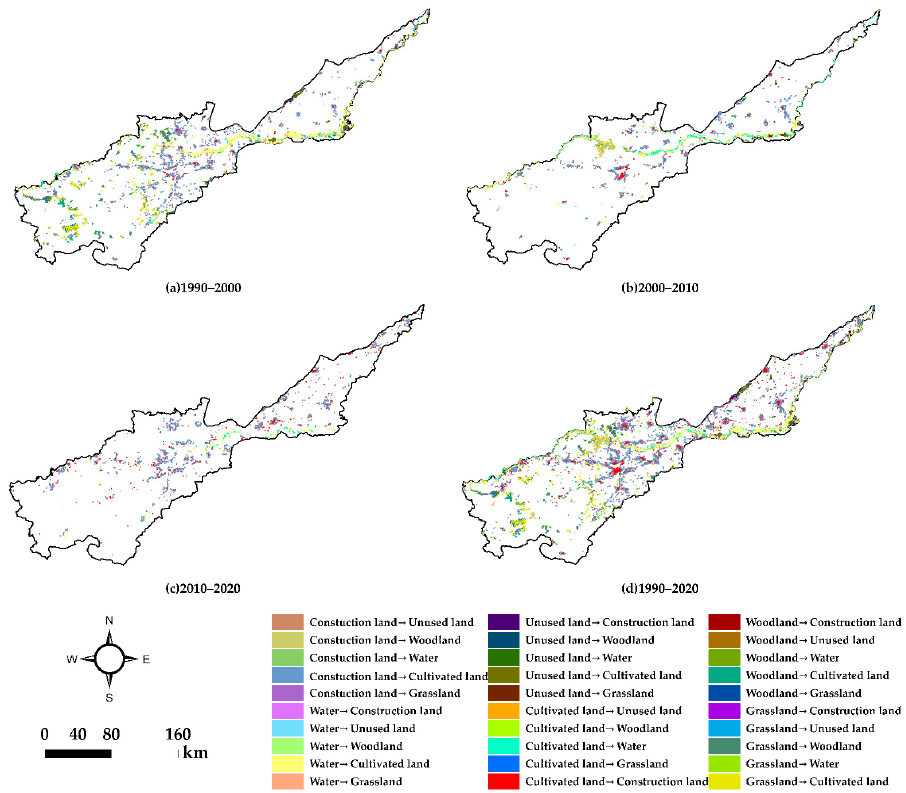
Figure 5. Spatial distribution of land use change in the Yellow River Basin (Henan section) from 1990 to 2020. According to the spatial analysis, the structure of the land use change in the Yellow River Basin (Henan section) from 1990 to 2020 was complicated (Figure 6). The stable structural type was the most widely distributed, accounting for 94.63% of the whole basin area, and it was mainly composed of two stable types: “cultivated land-cultivated land- cultivated land-cultivated land” and “woodland-woodland-woodland-woodland”, which indicates that the landscape pattern of the basin dominated by cultivated land has not changed fundamentally at present. The pre-change type accounted for 2.74% of the whole watershed area, and water area changing to cultivated land, cultivated land chang- ing to construction land, and grassland changing to cultivated land accounting for 28.71%, 20.86%, and 11.82% of the changing area in the pre-change type, respectively. The inter- mediate type accounted for 1.19% of the whole watershed area, mainly including “culti- vated land-cultivated land-construction land-construction land”, “cultivated land-culti- vated land-water area-water area”, and “water area-water area-cultivated land-cultivated land”, accounting for 38.79%, 26.67%, and 16.15% of this type of change structure area, respectively. The late-stage change type accounted for 0.82% of the watershed area, which